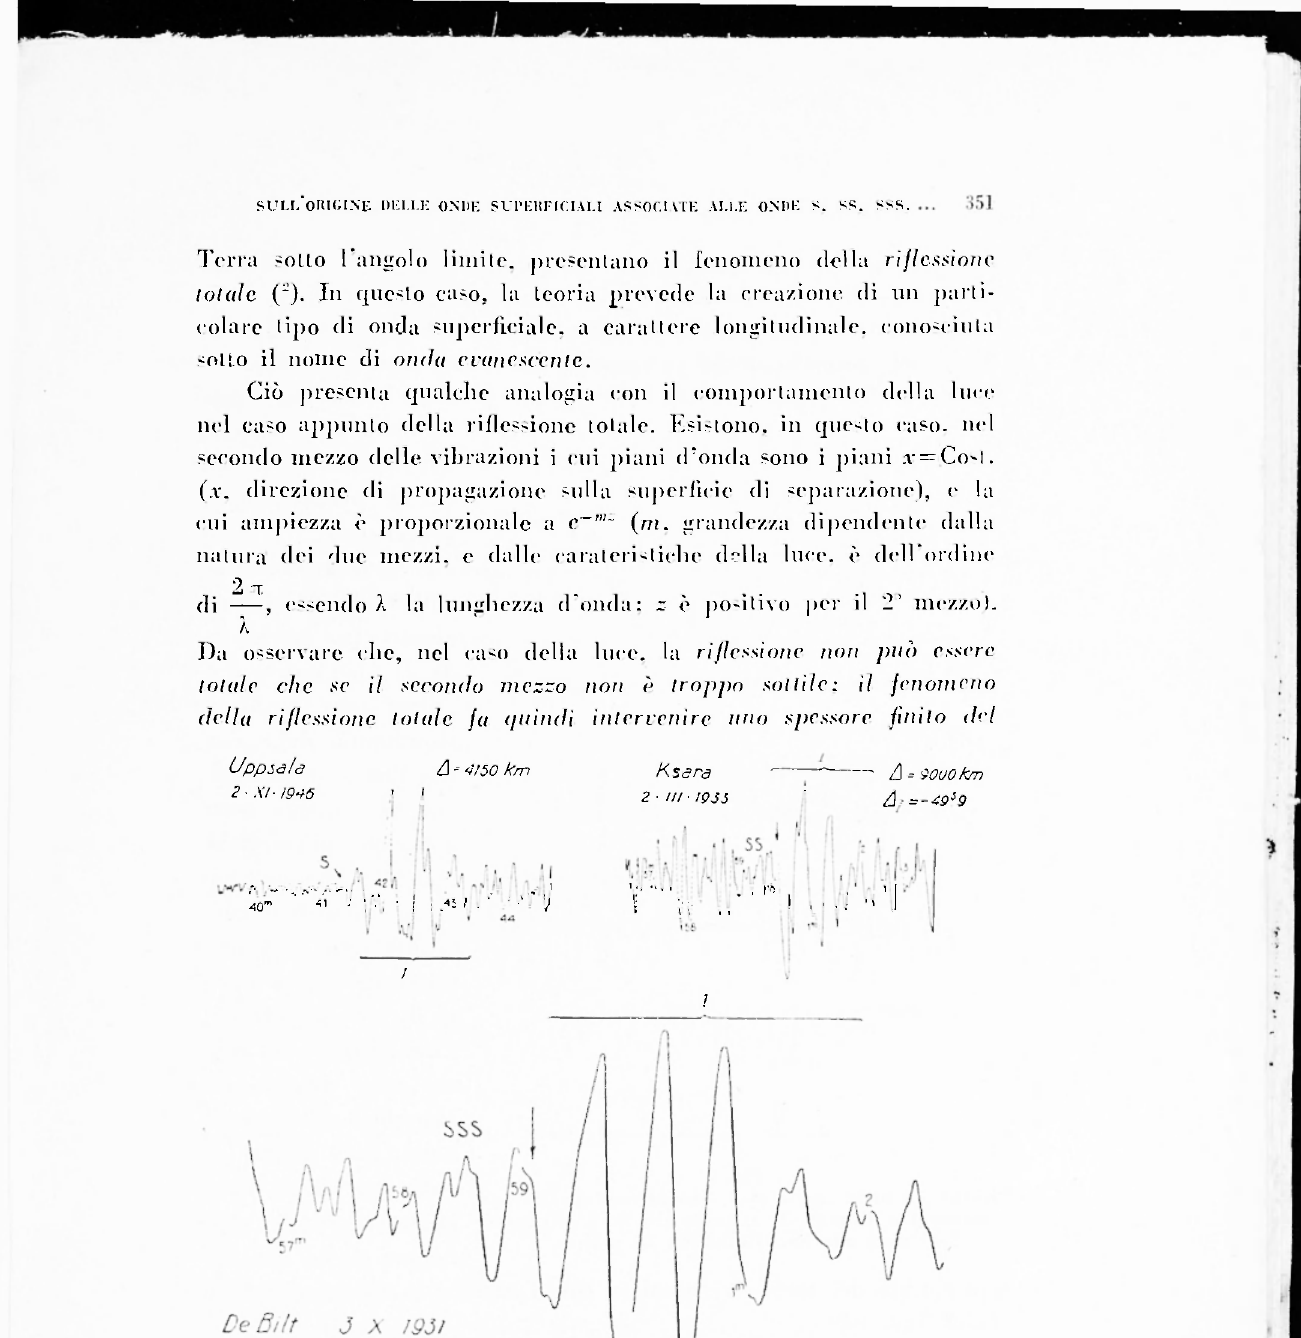
Fig. 1 Esempi di onde tipo 1 (C,'i. con periodo di 35 s ca.. originanti a distanza A-associate alla S: 2 A- associate alla SS: 3 A- associate alla SSS. I Ridu- zione ca.